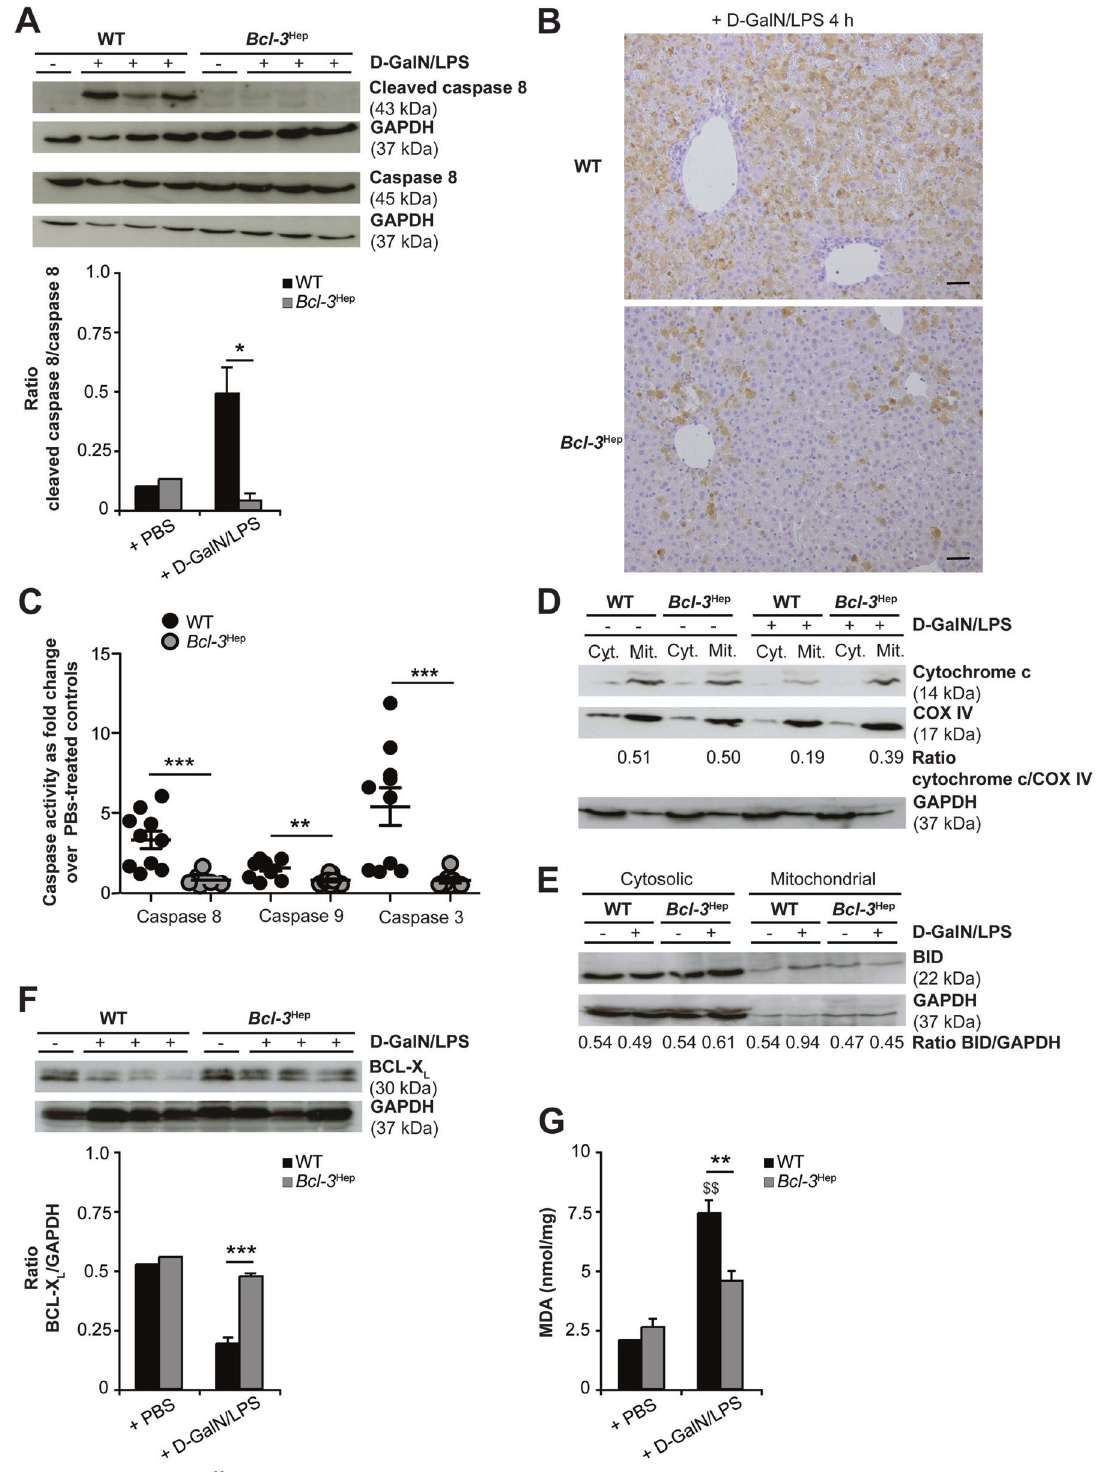
Fig. 2 Hepatoprotection in Bcl-3 Hep mice against d-GalN/LPS is associated with a reduction of caspase activation, BCL-X L degradation and mitochondrial ROS formation. Liver tissue of d-GalN/LPS-challenged Bcl-3 Hep and WT mice was harvested after 4 h for immunodetection of A activated caspase 8 by immunoblotting, B activated caspase 3 by immunhistochemical staining, and C activated caspase 8, 9, and 3 by caspase enzyme assays (means of n = 10 mice/group ± SEM). Activation of the mitochondrial apoptotic pathway was further evaluated by immunoblotting of D cytochrome c and E BID in cytosolic (cyt.) and mitochondrial (mit.) protein fractions, F BCL-X L in whole liver tissue lysates, and G determination of MDA content (means of n = 10 WT + d-GalN/LPS, n = 6 Bcl-3 Hep + d-GalN/LPS, n = 2 PBS-treated controls per genotype ± SEM). In A and D – F representative immunoblots with densitometric analysis are shown. GAPDH and COX IV served as protein loading controls. In B representative histological photomicrographs (scale bar: 2000 µM) are depicted. * p < 0.05, ** p < 0.01, *** p < 0.001 for WT vs. Bcl-3 Hep and $$ p < 0.01 for PBS vs. d-GalN/LPS using unpaired, two-tailed Student ’ s t -test ( A , F , and G ) or Mann – Whitney U test ( C ).